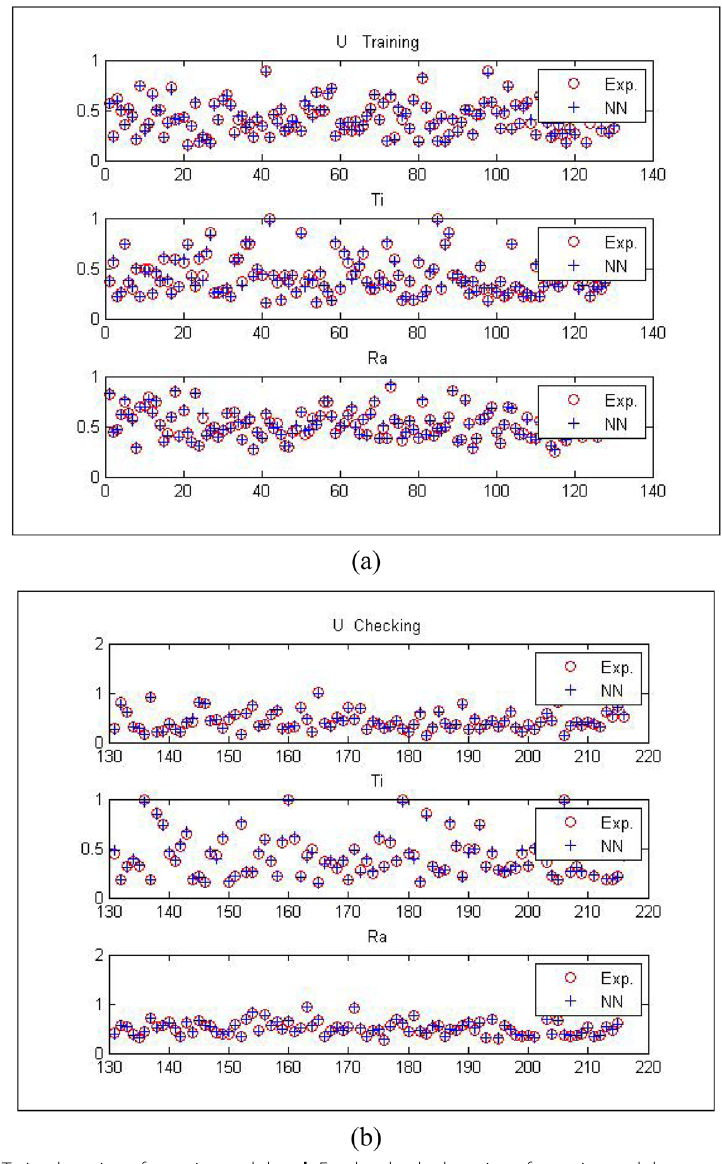
Fig. 4 a Trained portion of experimental data. b For the checked portion of experimental data